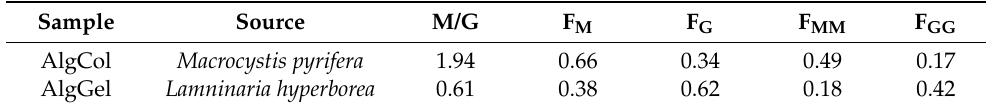
Table 4. The source, molar fraction (F) of individual monomers, and the respective blocks of man- nuronic (M) and guluronic (G) monomers on AlgGel and AlgCol [80]. Sample Source M/G F M F G F MM F GG AlgCol Macrocystis pyrifera 1.94 0.66 0.34 0.49 0.17 AlgGel Lamninaria hyperborea 0.61 0.38 0.62 0.18